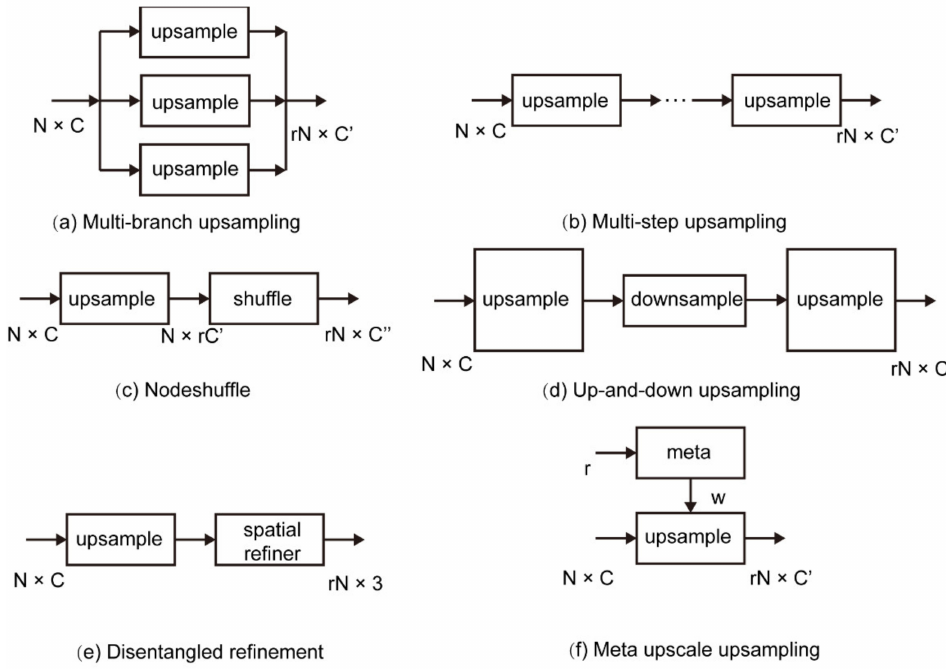
Figure 3. Several common upsampling component frameworks. C , C (cid:48) and C (cid:48)(cid:48) are the features of the point, r is the upsampling rate, w is the weight. Subfigures are described in detail in Section